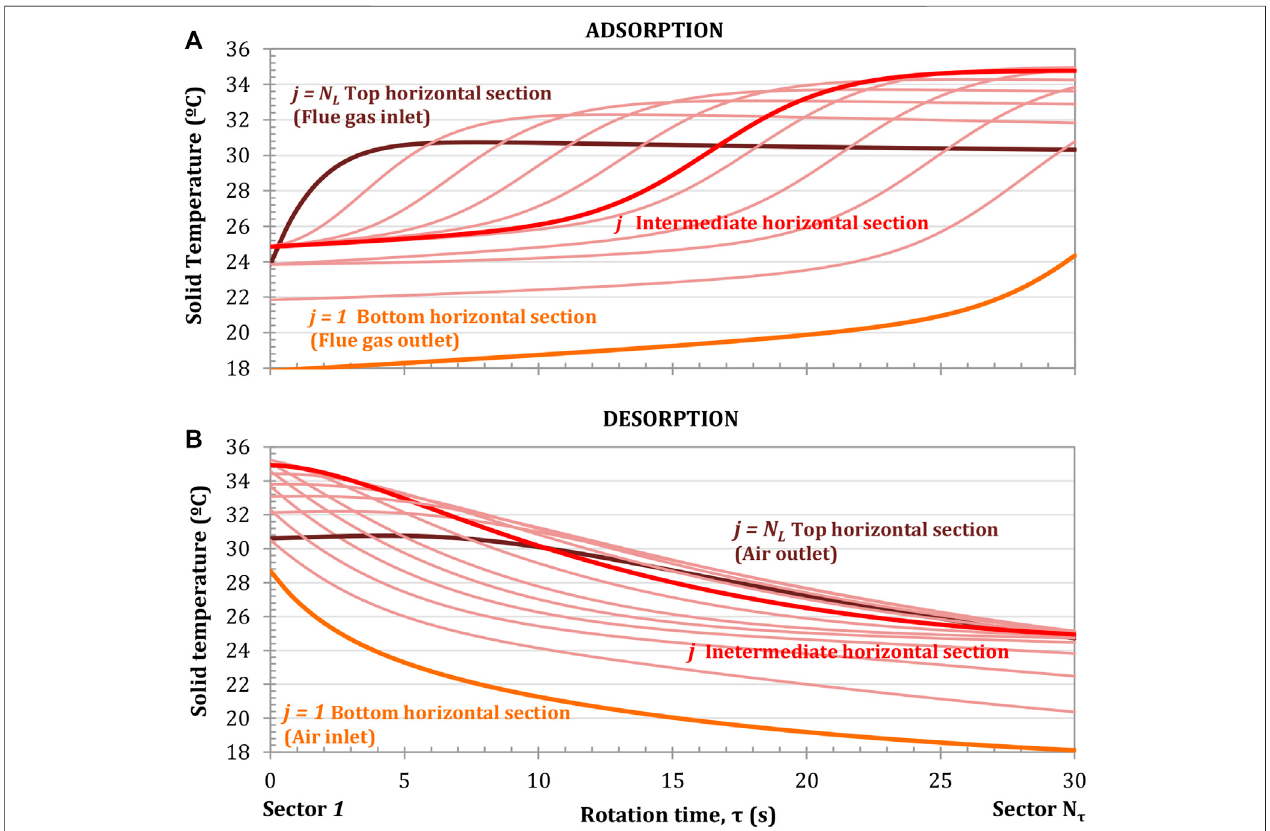
FIGURE 9 | Cumulative working capacity of the adsorbent in the longitudinal direction. Con fi guration: parallel S-EGR at 70% recirculation ratio. Adsorbent: Activated Carbon.